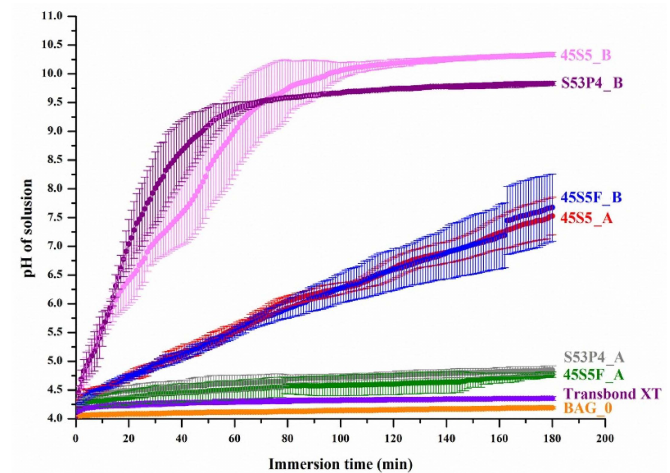
Figure 4. Time-dependent changes of the pH in acid